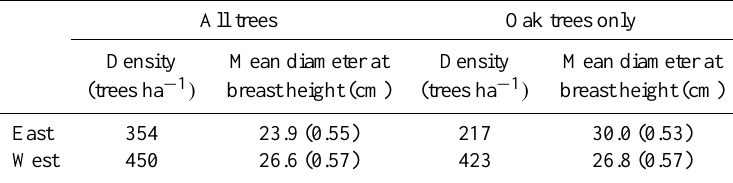
Table 1. Results of tree mensuration surveys carried out in 2009 (west sector) and 2011 (east sector) at the Straits Inclosure, Alice Holt Forest. In the east sector, 26 circular plots were measured, each with a radius of 12.6m, whilst in the west sector, 18 plots were measured, each with a plot radius of 8m. Plot locations were selected using a stratified grid basis to ensure the heterogeneity of the forest structure was measured; figures in brackets are standard error. All trees Oak trees only